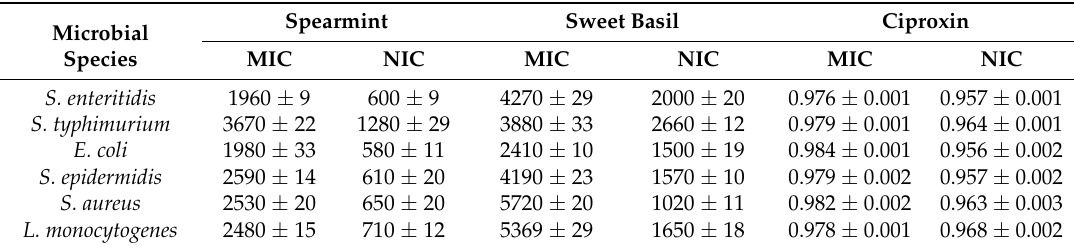
Table 5. MICs and NICs (mg/L) of the essential oils against common food spoilage and pathogenic